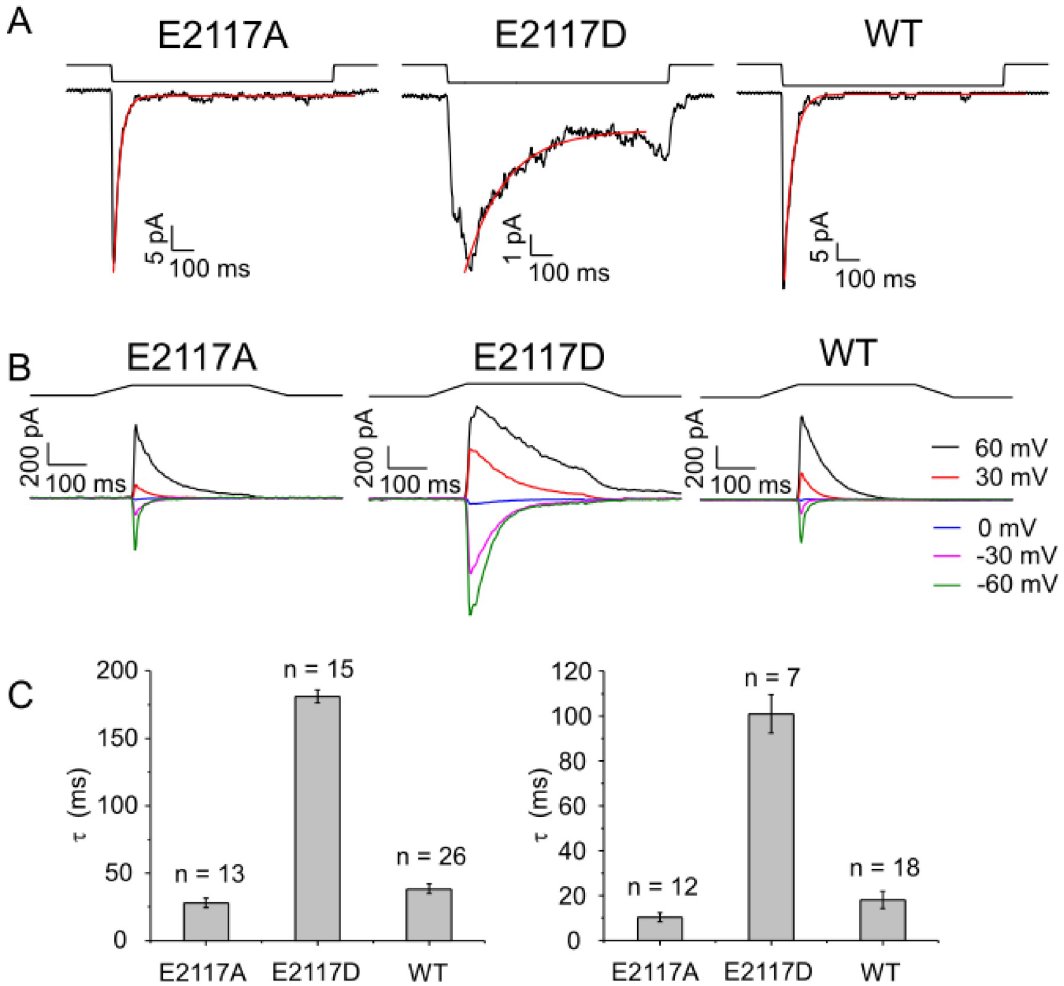
Fig 2. A conservative mutation of glutamic to aspartic acid slows inactivation. (A) shows cell-attached patch currents comparing the inactivation rates of E2117A, E2117D and wild-type. The inactivation time constant fit to a single exponential (red trace). The inactivation rate derived for E2117A (Left) is nearly identical to wild-type (Right) , but E2117D (Middle) is ~ 6 fold slower. (B) shows inactivation of whole-cell currents for the two mutants at -60 mV. The inactivation of E2117D is ~10-fold slower than E2117A. The latter’s inactivation rate is similar to that of the wild-type. (C) shows the inactivation time-constant averaged across multiple patches and cells. Results are summarized in the bar graph. For cell-attached patches, the inactivation time-constants for E2117A, E2117D and wild-type at– 100 mV were τ = 28.0 ± 3.4 ms, 181.3 ± 4.7 ms, and 38.4 ± 3.6 ms, respectively. For whole-cell recordings, the inactivation time constants at -60 mV for E2117A, E2117D, and wild-type were τ = 10.2 ± 1.7 ms, 101.2 ± 8.7 ms, and 17.6 ± 3.8 ms,